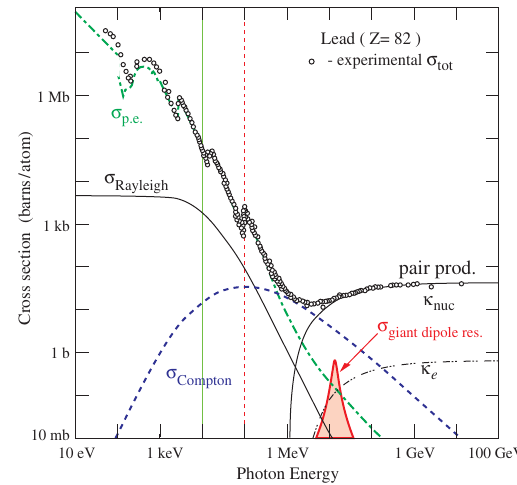
FIG. 6. Photon total cross section as a function of energy in lead showing the contribution of different processes. Green line is at 10 keV, red line is at 100 keV. Reference